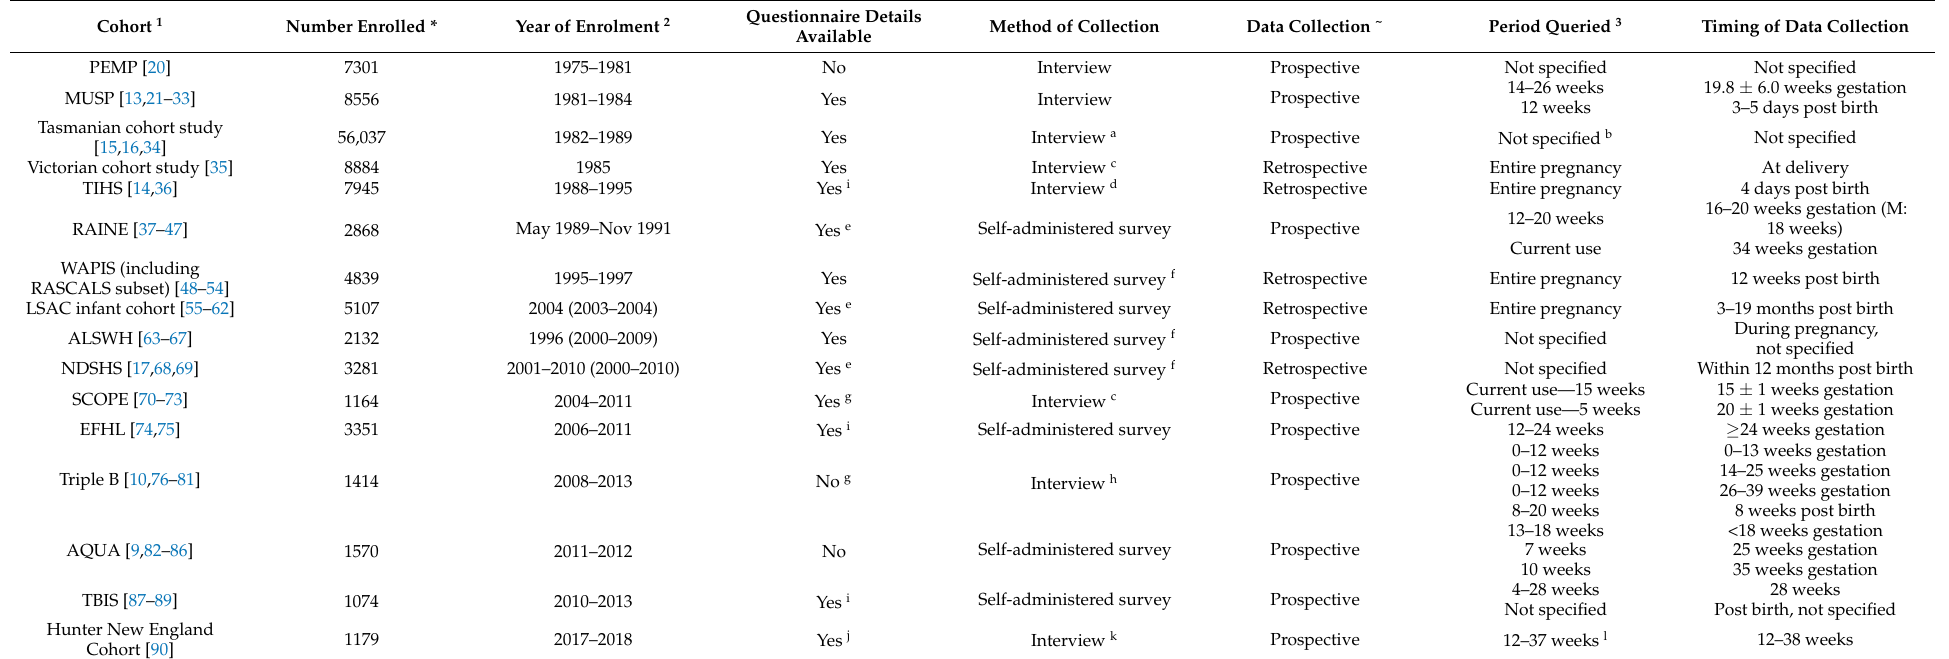
Table 1. Cohort enrolment and method of data collection on prenatal alcohol